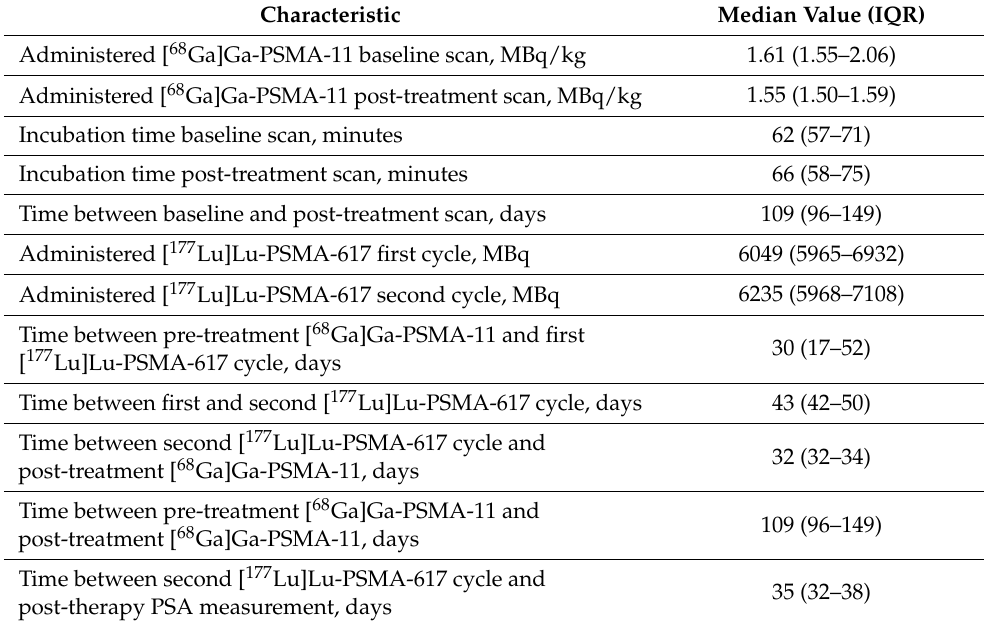
Table A2. Baseline imaging and pharmaceutical